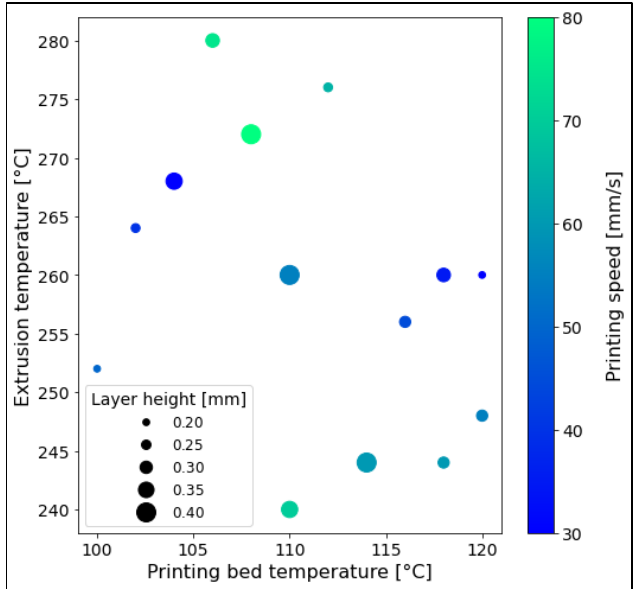
Figure 4. Conditions evaluated for the validation of the DoE-based prediction model.